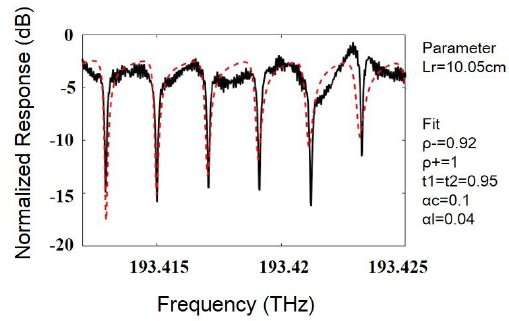
Figure 10. Measured resonance curve and the fitting results of the silicon dioxide WRR.